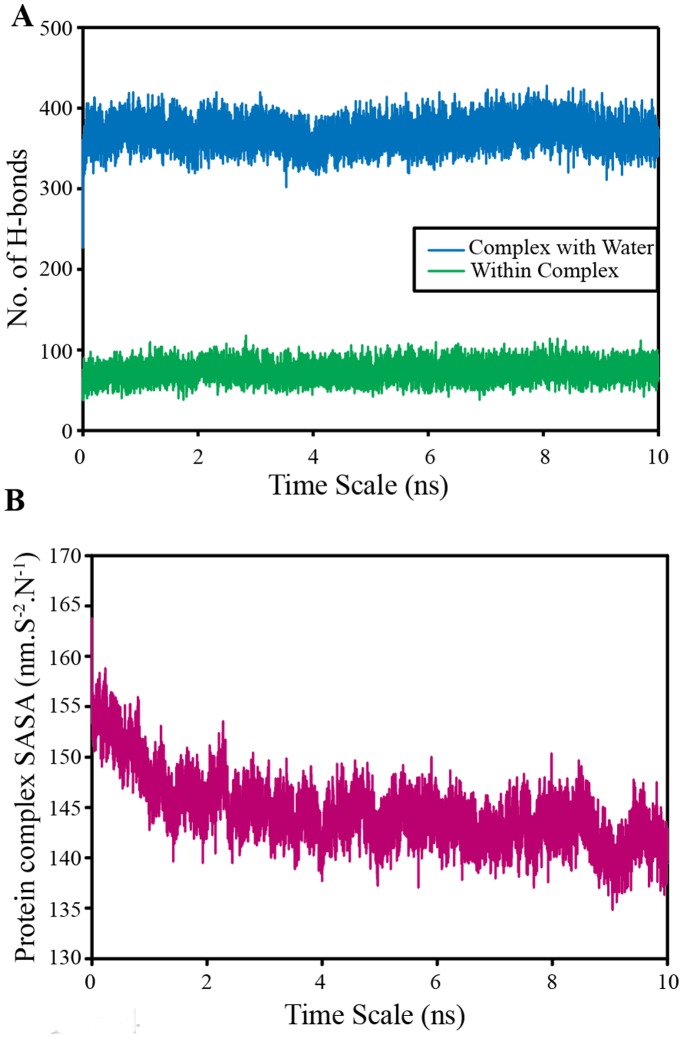
Hydrogen bonding profile & solvent accessibility.(A) Hydrogen bonding profile indicating numbers of hydrogen bonds formed within protein atoms and with water molecules. (B) Solvent accessible surface area computed over the simulation time course.